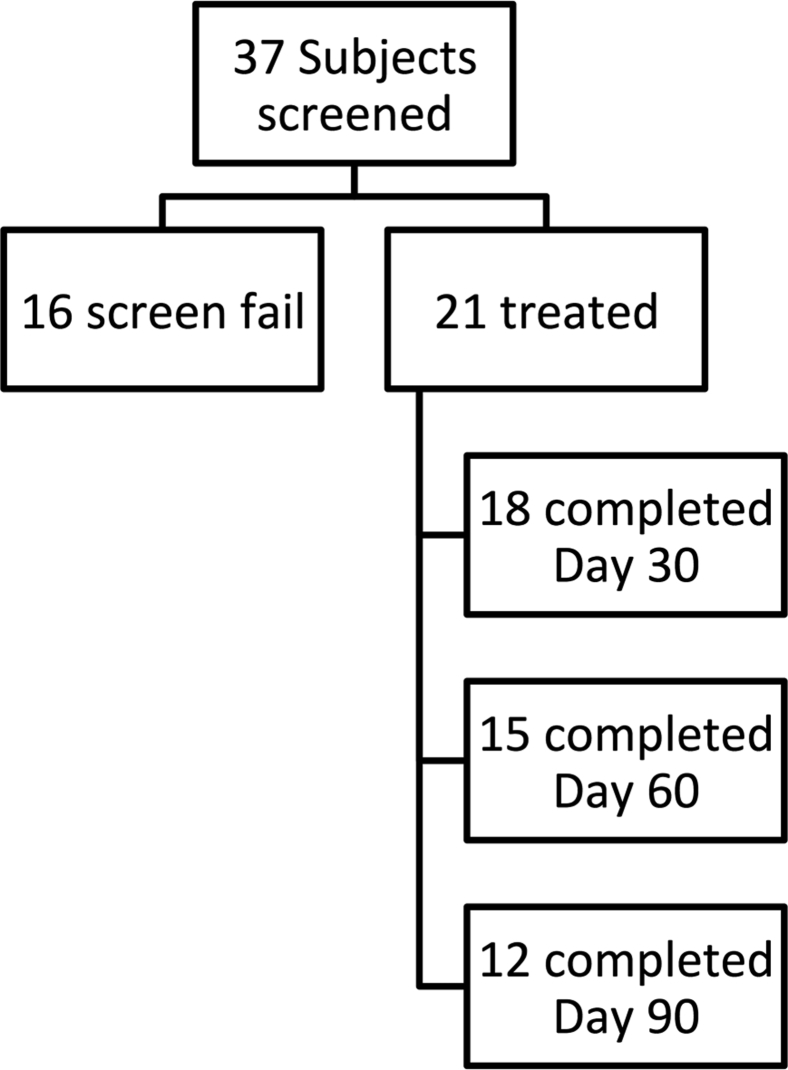
The schematic shows numbers of patients initially enrolled in the study and who subsequently progressed to treatment and attended for follow-up. Of the 9 patients who failed to complete day-90 follow-up, 5 were withdrawn from the study due to adverse events unrelated to treatment, 3 were referred to other interventions (radiation therapy), and 2 chose to withdraw from the study due to declining health.